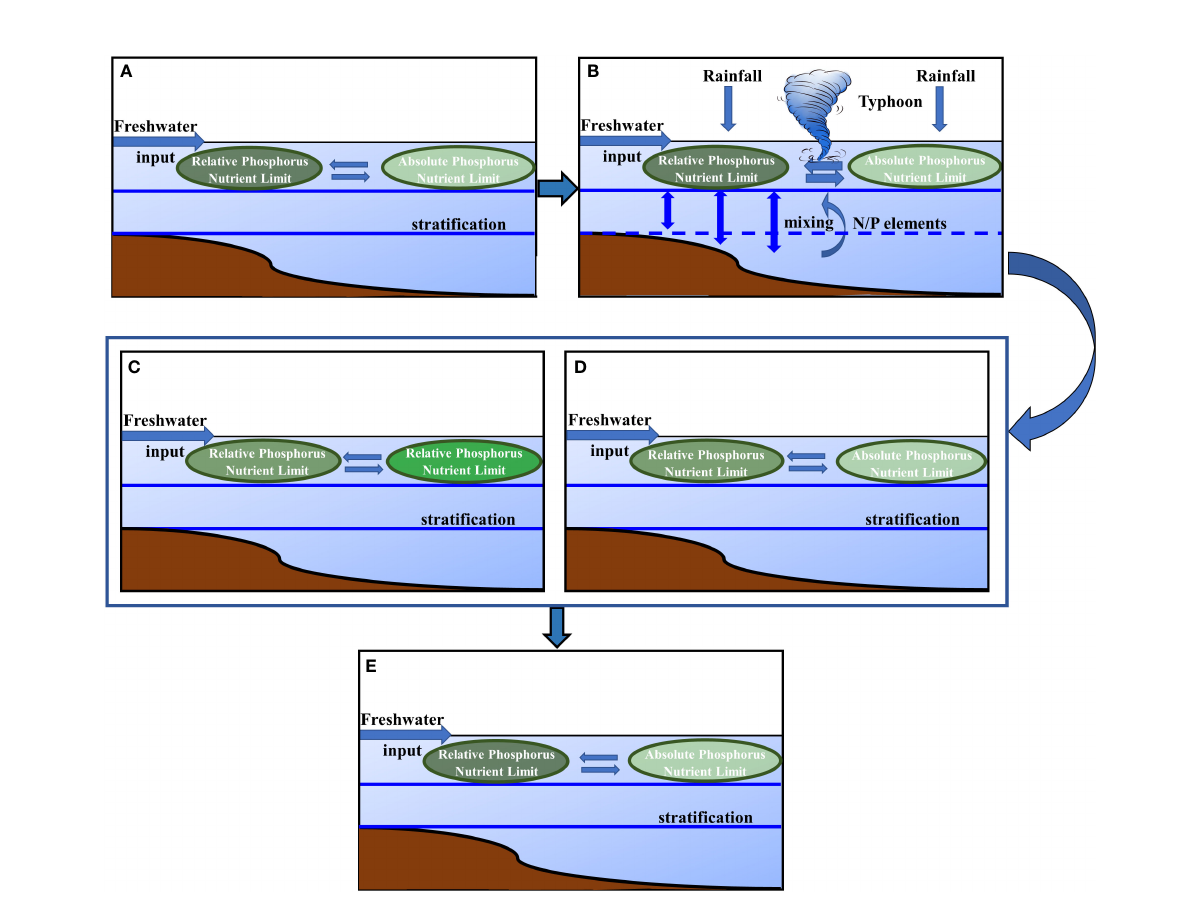
FIGURE 1 Schematic diagram of changes in nutrient status before the typhoon (A) , during the typhoon (B) , and after the typhoon (C – E) . Among them, (C, D) show two kinds of statuses may occur within a short time after the typhoon passes by, and (E) shows the status after a period of time after the typhoon passes